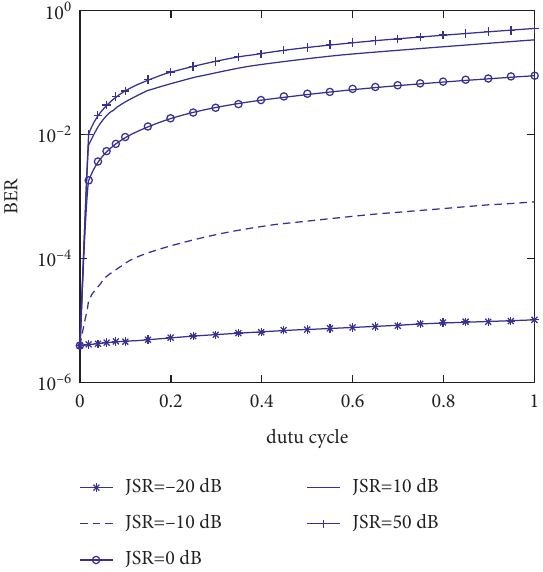
Figure 1: The simulation result of BER with pulse